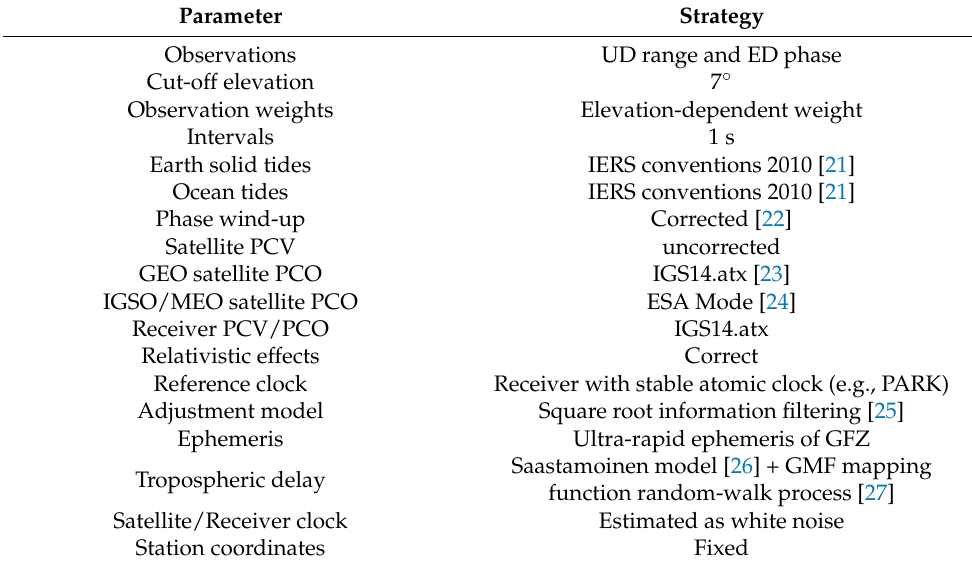
Table 1. Estimation strategy of real-time clock offset.